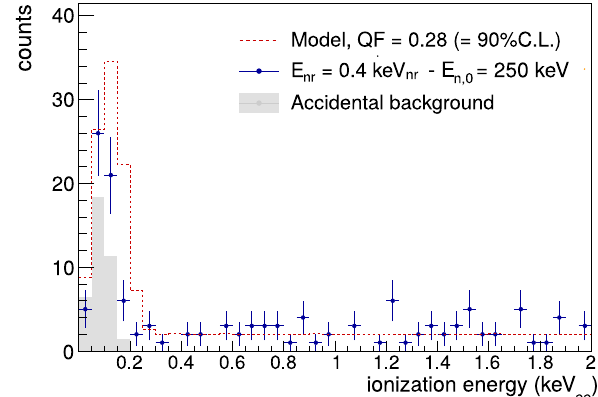
Fig. 12 Coincidence energy distributions obtained in the HPGe detec- toraftercoincidenceselectionwiththreeLSdetectorsatdifferentangles for the data set with the neutron beam energy E n , 0 = 500keV. The accidental contribution, here in gray, is determined by opening ran- dom windows and consists of electronic noise. The best-fit models are superimposed in dashed lines